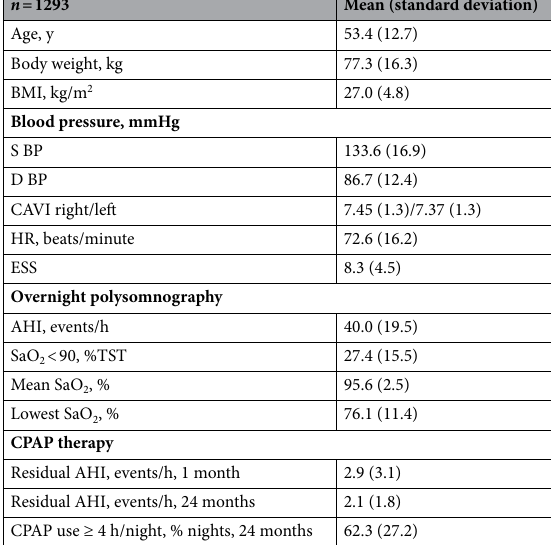
Table 1. Clinical characteristics of patients and data from sleep study. Data expressed as mean (standard deviation); S BP systolic blood pressure, D BP diastolic blood pressure, HR heart rate, CAVI Cardio Ankle